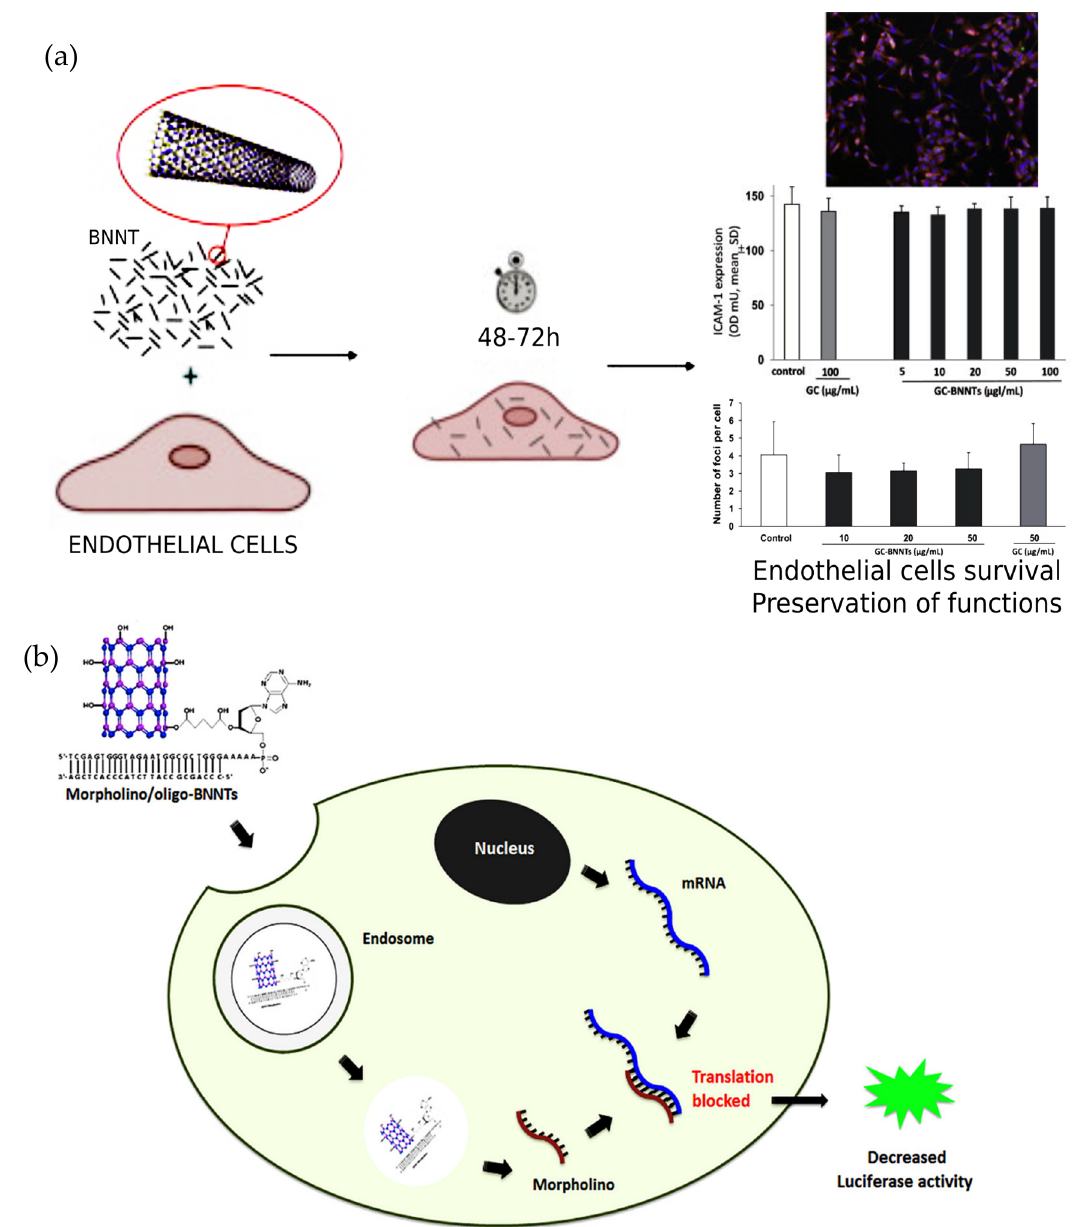
Figure 4 ( a ) Illustration of cell viability assay. Reproduced with permission from Ref [67]. Copyright 2013 Elsevier; ( b) Morpholino-oligo-BNNTs cultured with MDA-MB-231-luc2 cells to evaluate gene slicing efficiency. Reproduced with permission from Ref [46]. Copyright 2017, Elsevier.